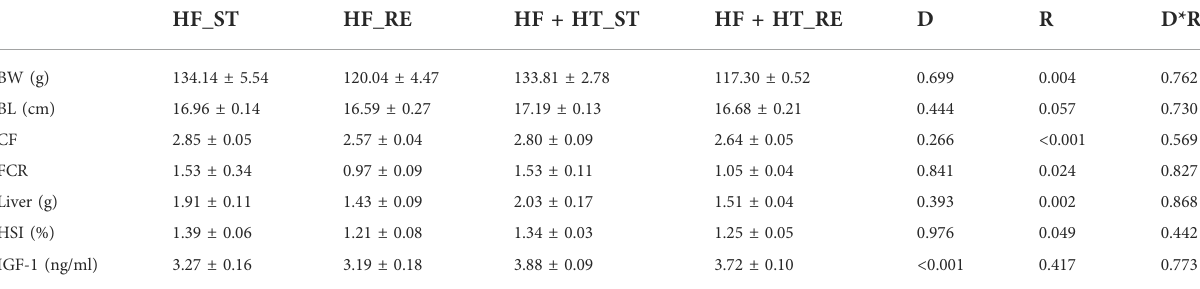
Data are shown as Mean ± SEM ( n = 3 tanks, except for IGF-1 plasma levels n = 10 fi sh). Statistical differences are indicated in 3 components: diet (D), ration (R) and interaction (D*R), using two-way ANOVA ( p < 0.05). BW, body weight; BL, body length; CF, condition factor (BW/BL 3 ) × 100; FCR, feed conversion ratio (g total feed intake/(BW- initial BW); HSI, hepatosomatic index (liver weight/BW) × 100.